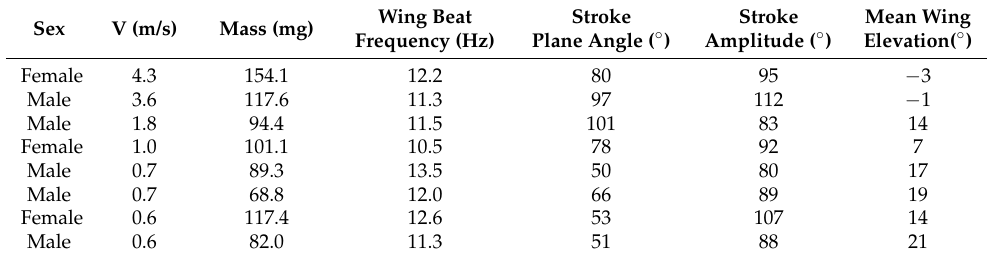
Table 1. Sex, velocity, mass and wing kinematics for Heliconius sara